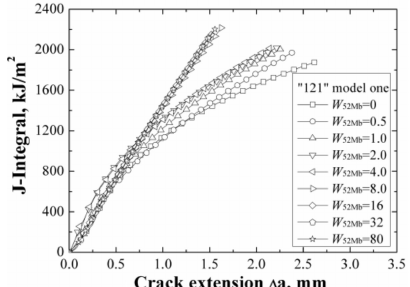
Figure 5. The J -resistance curves of different “121”